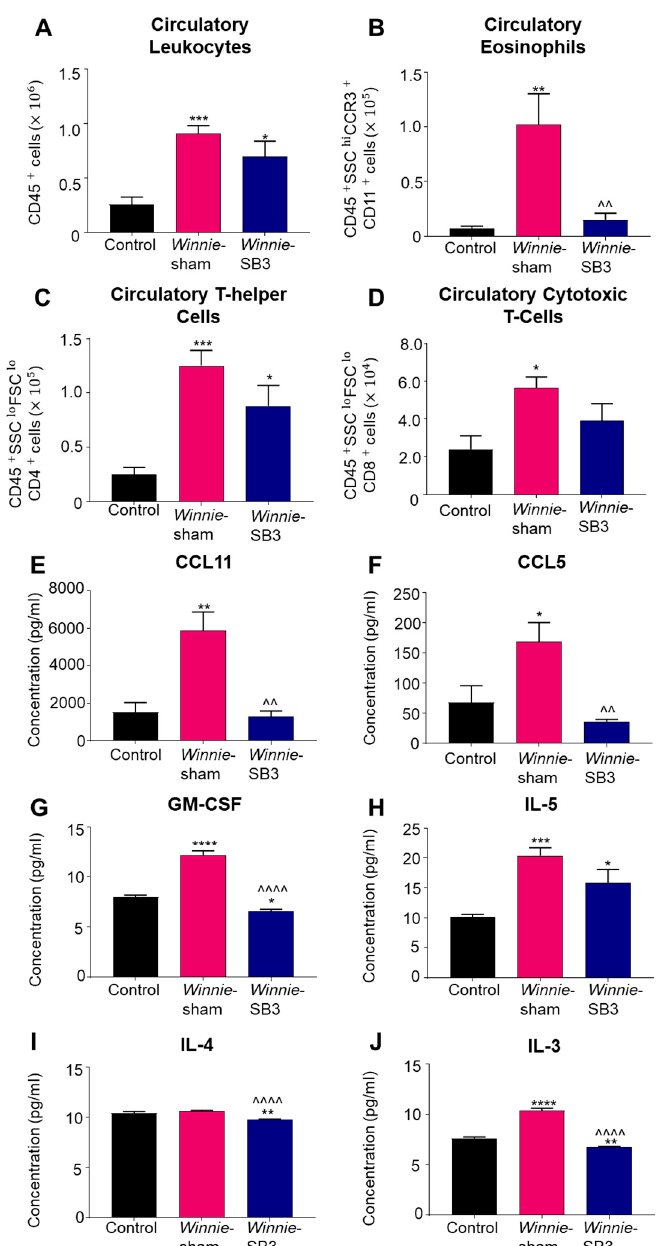
Figure 5. The effects of SB3 treatment on circulating leukocytes and serum levels of eosinophil-associated analytes. ( A – D ) The number of infiltrating CD45 + leukocytes, CD45 + SSC + CCR3 + CD11b + eosinophils, CD45 + SSC LO FSC LO CD4 + T helper, and CD45 + SSC LO FSC LO CD8 + cytotoxic T cells measured in the blood sera from control, sham-treated, and SB3-treated Winnie mice ( n = 6/group). ( E , F ) Concentrations of CCR3-associated chemokines, CCL11 and CCL5 (pg/mL), measured in the blood sera from control ( n = 6), sham-treated Winnie ( n = 6), and SB3-treated Winnie ( n = 5) mice. ( G – J ) Concentration of eosinophil-associated cytokines GM-CSF, IL-5, IL-4, and IL-3 (pg/mL) quantified in the blood sera from control ( n = 6), sham-treated Winnie ( n = 6), and SB3-treated Winnie ( n = 5) mice. Data expressed as mean ± SEM; * p < 0.05, ** p < 0.01, *** p < 0.001, **** p < 0.0001 compared to control mice; ^^ p < 0.01, ^^^^ p < 0.0001 compared to sham-treated Winnie mice. Concentrations of eosinophil-associated chemokines (CCL11 and CCL5) and cyto- kines IL-3, IL-4, IL-5, and GM-CSF, which play important roles in eosinophil maturation, chemotaxis, and activity, were measured in sera. Significant increases in concentrations of both CCL11 ( p < 0.01, n = 6) and CCL5 ( p < 0.05, n = 6) chemokines were evident in sham-